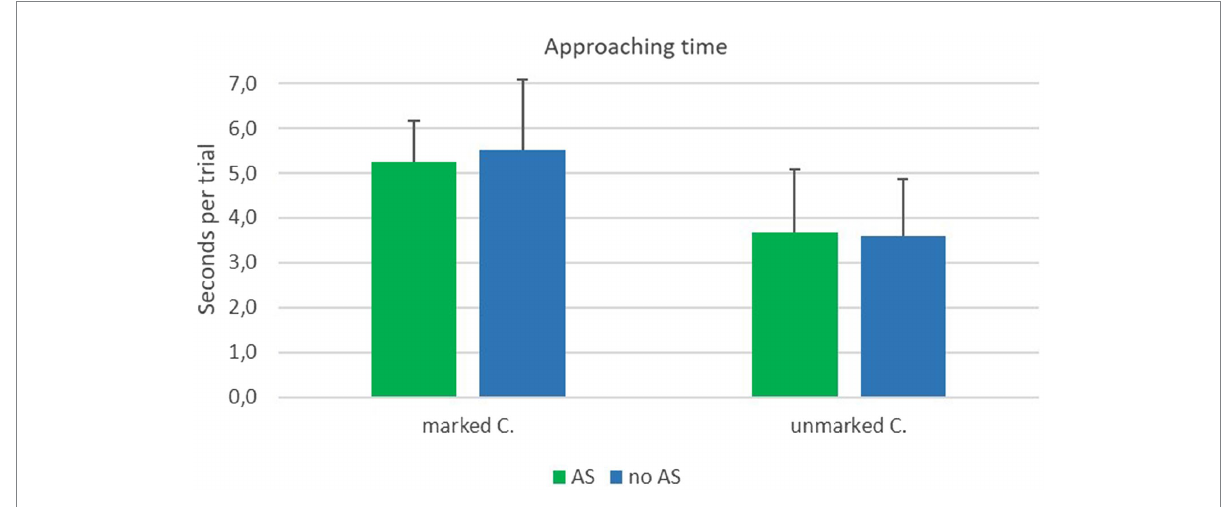
FIGURE 11 Means of approaching time in the field experiment at marked and unmarked crossings with (AS) and without (nAS) assistance